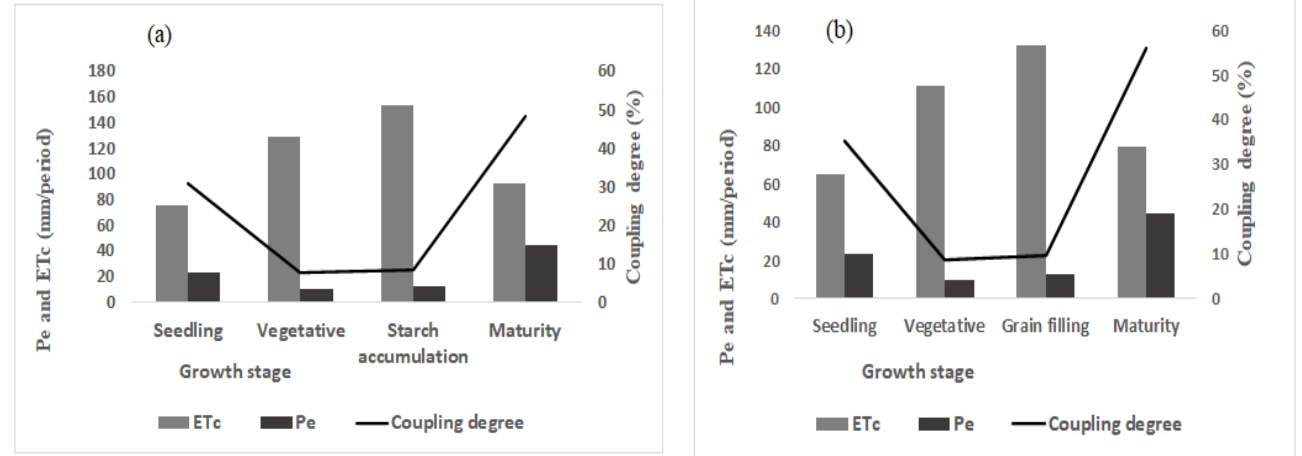
Figure 5. Mean monthly ET o and rainfall in the irrigation season.